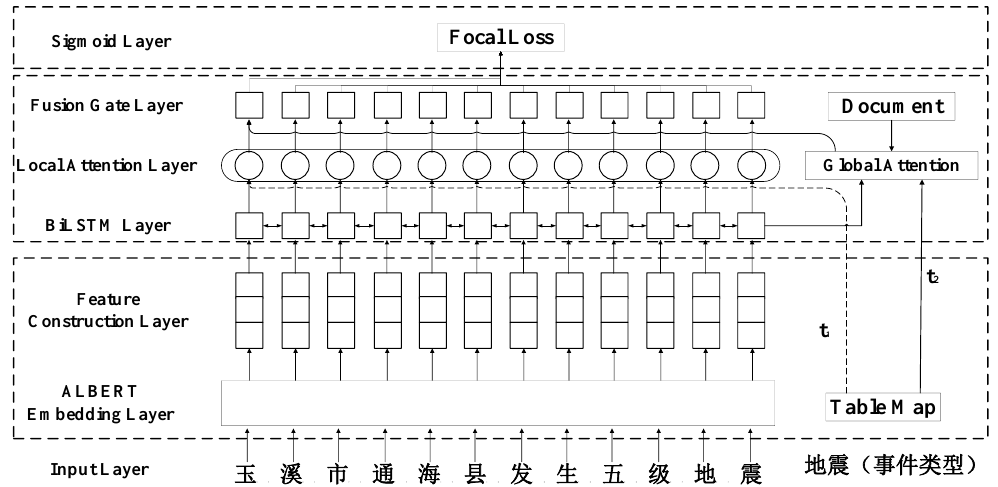
Figure 3. The architecture of event detection without triggers based on dual attention.